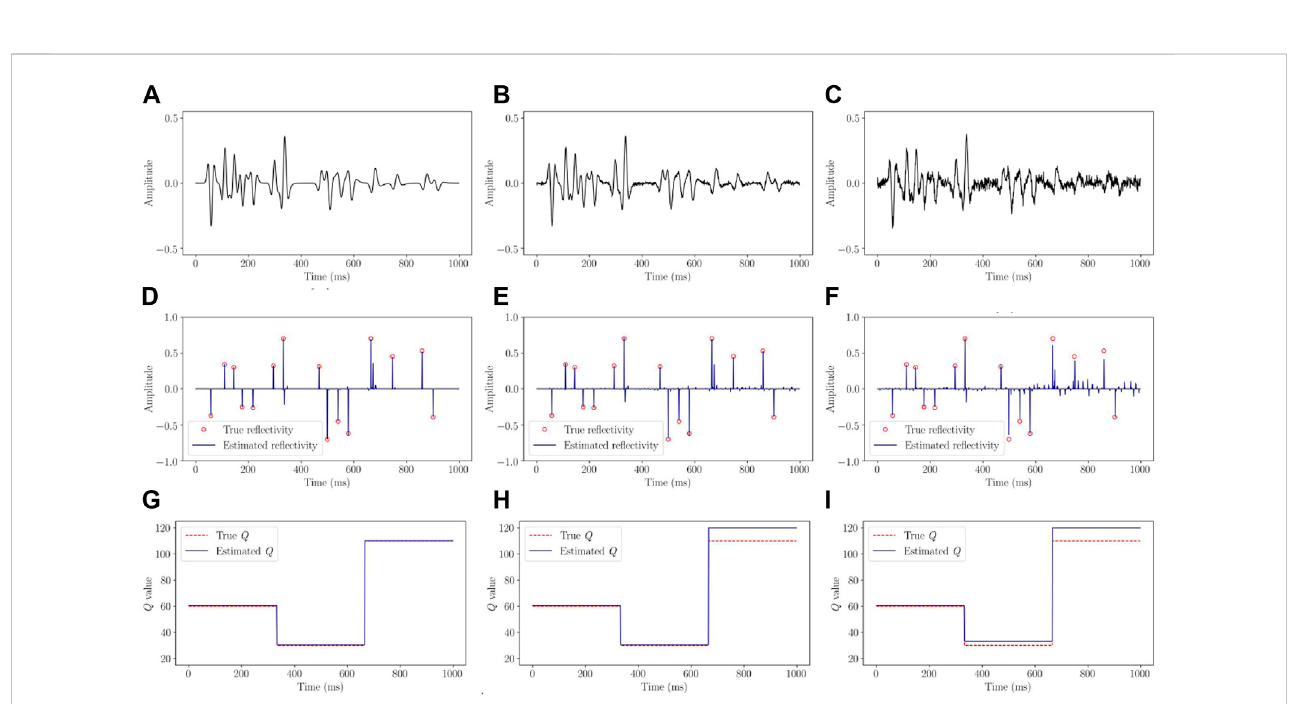
FIGURE 6 Complexsynthetictracesattenuatedbyusinginterval- Q model( Q =60,30,110)andcontaminatedbyrandomnoisesofdifferentlevels: (A) 0.1%, (B) 5%, and (C) 10%. The estimated re fl ectivity series are shown in (D – F) . The true non-zero re fl ectivity coef fi cients are shown by the red points. The corresponding estimations of the Q values are showed in (G – I) . The true Q values are shown in red